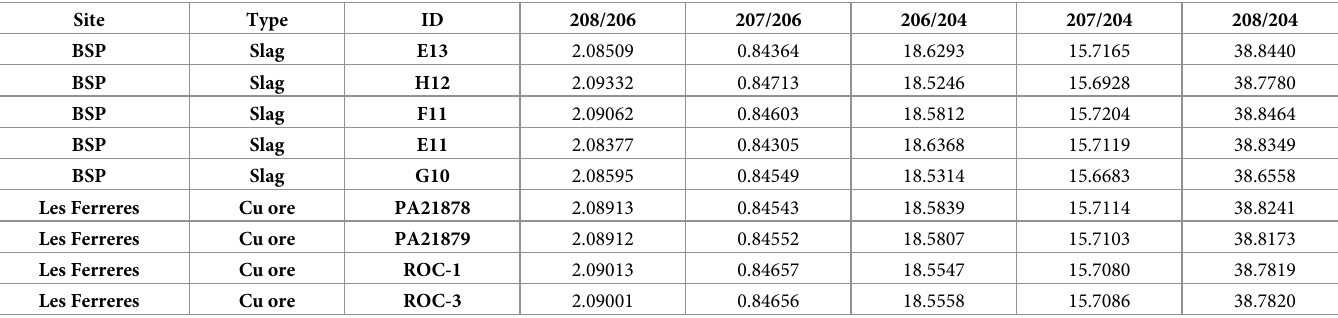
Table 9. LIA results for La Bauma and Les Ferreres samples